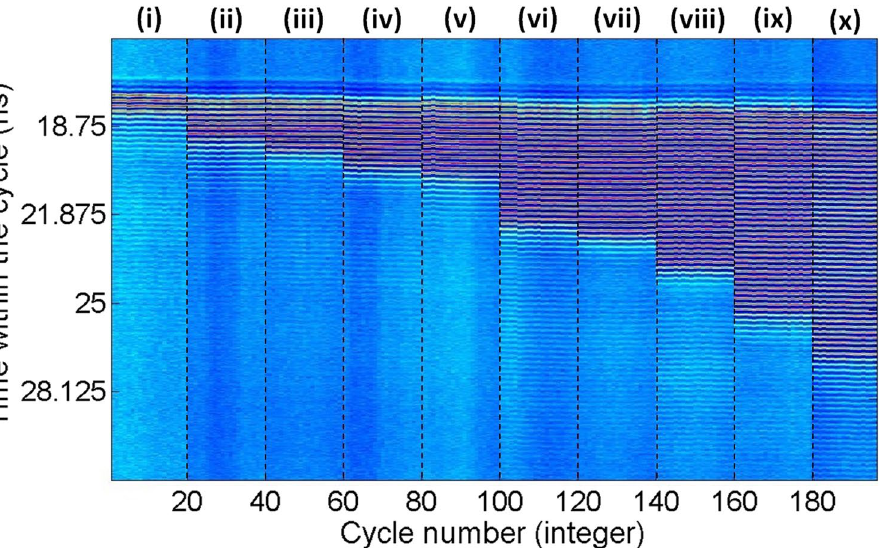
Figure 5. Merged temporal maps obtained for 10 cases of t d : (i) 0.75 ns, (ii) 1.83 ns, (iii) 2.23 ns, (iv) 2.76 ns, (v) 3.05 ns, (vi) 4.79 ns, (vii) 5.15 ns, (viii) 6.42 ns, (ix) 8.02 ns & (x) 9.80 ns. Each map displays the system’s response to 20 consecutive